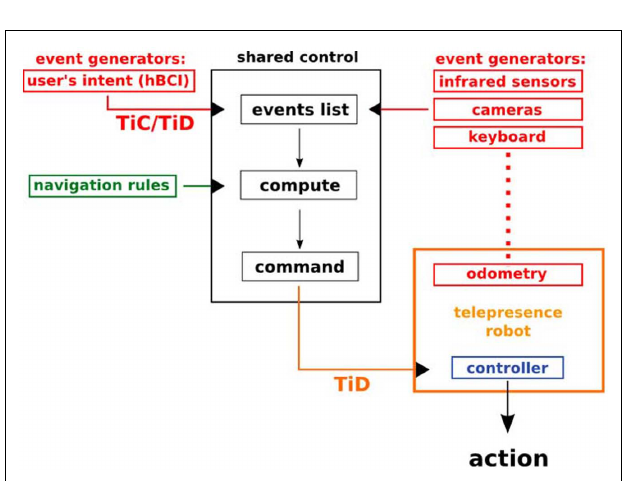
FIGURE 5 | Schema of shared control module. This figure shows an example of shared control for a mobile device. However, the same schema can be used for different kinds of